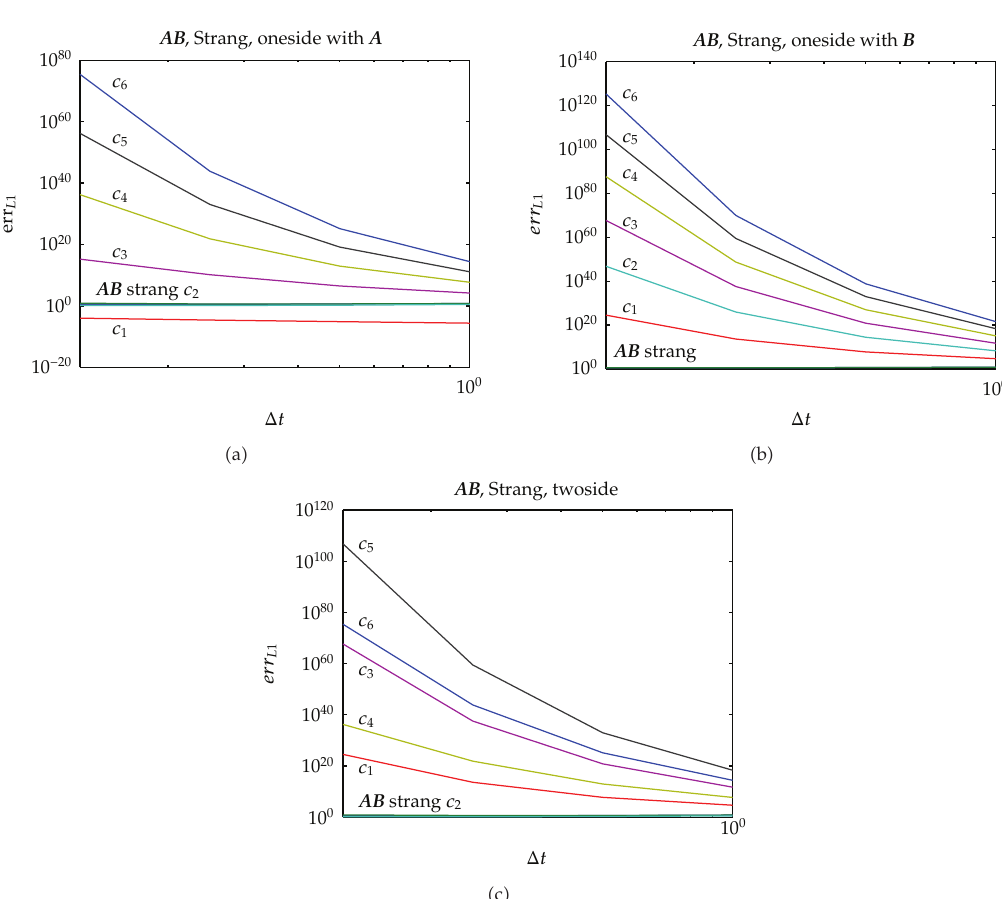
Figure 8: Numerical errors of the one-side splitting scheme with A (cid:5) a (cid:6) , the one-side splitting scheme with B (cid:5) b (cid:6) and the iterative schemes with 1 ,... , 6 iterative steps (cid:5) c (cid:6)